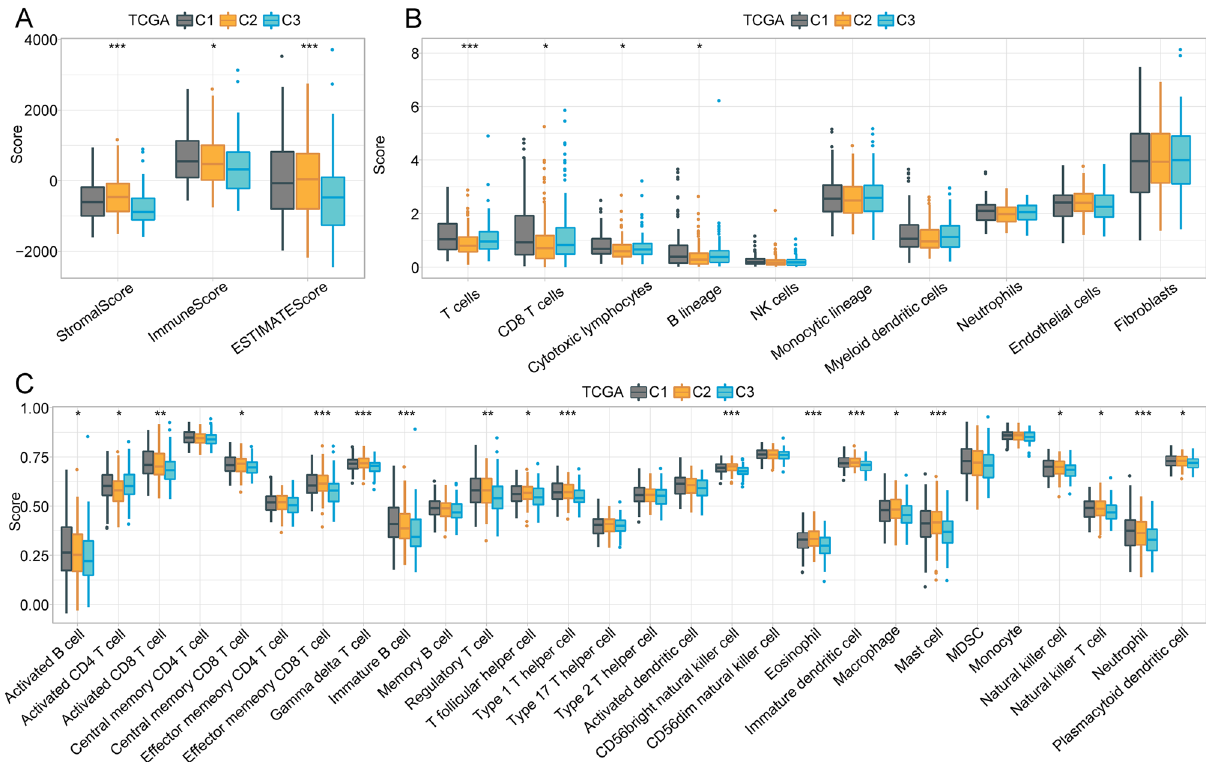
Figure 5. Immune features across the three subtypes in the TCGA datasets. ( A ) Immune microenvironment scores across subtypes (TCGA). ( B ) Differential infiltration of immune cells in three subtypes (TCGA). ( C ) Differences in scores for immune-related pathways across the three